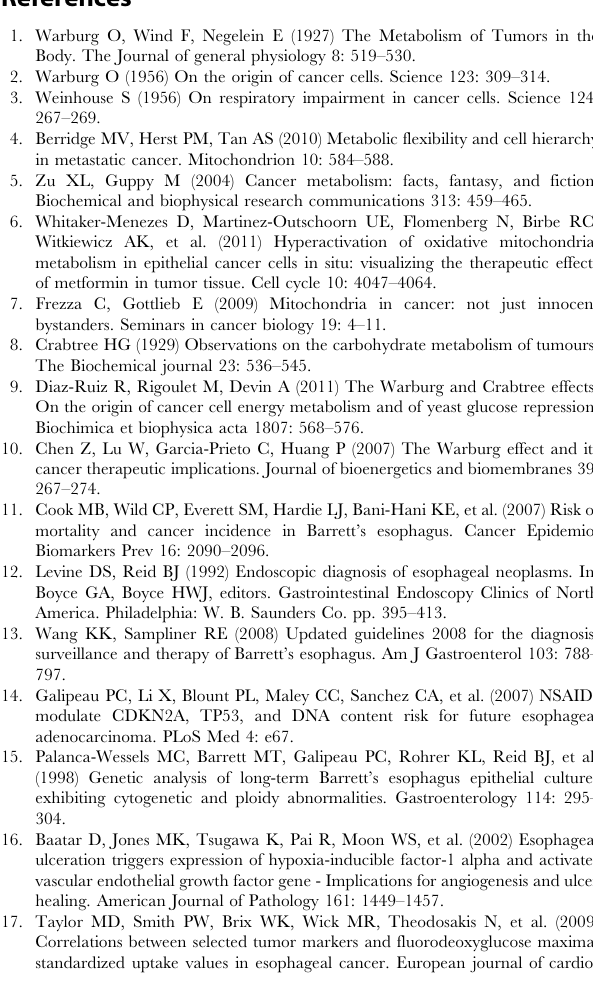
Table S6 Analysis of copy number alterations of genes involved glycolysis, oxidative phosphorylation and hyp- oxia regulation in BE cell lines. Gene symbol is the human genome Gene Symbol for the gene. Copy number gains are marked as ‘ + ’ and single copy losses as ‘ 2 ’. No double copy losses were detected in the genes investigated. * Note that prolyl 4- hydroxylases are inhibitors of HIF-1 mediated hypoxic resistance. Table S7 Summary of copy number alterations in nuclear-encoded mitochondrial genes. 1023 mitochondrial genes were characterized for deletions, gains of copy number, and copy neutral loss of heterozygosity (LOH). Table S8 Summary of mitochondrial mutations in BE derived cell lines. Nucleotides for mutation locations and haplogroup designation based upon data from Mitomaster mitochondrial mutation database and analysis tool [26]. * indicates mutations that share their location with a known human mitochondrial